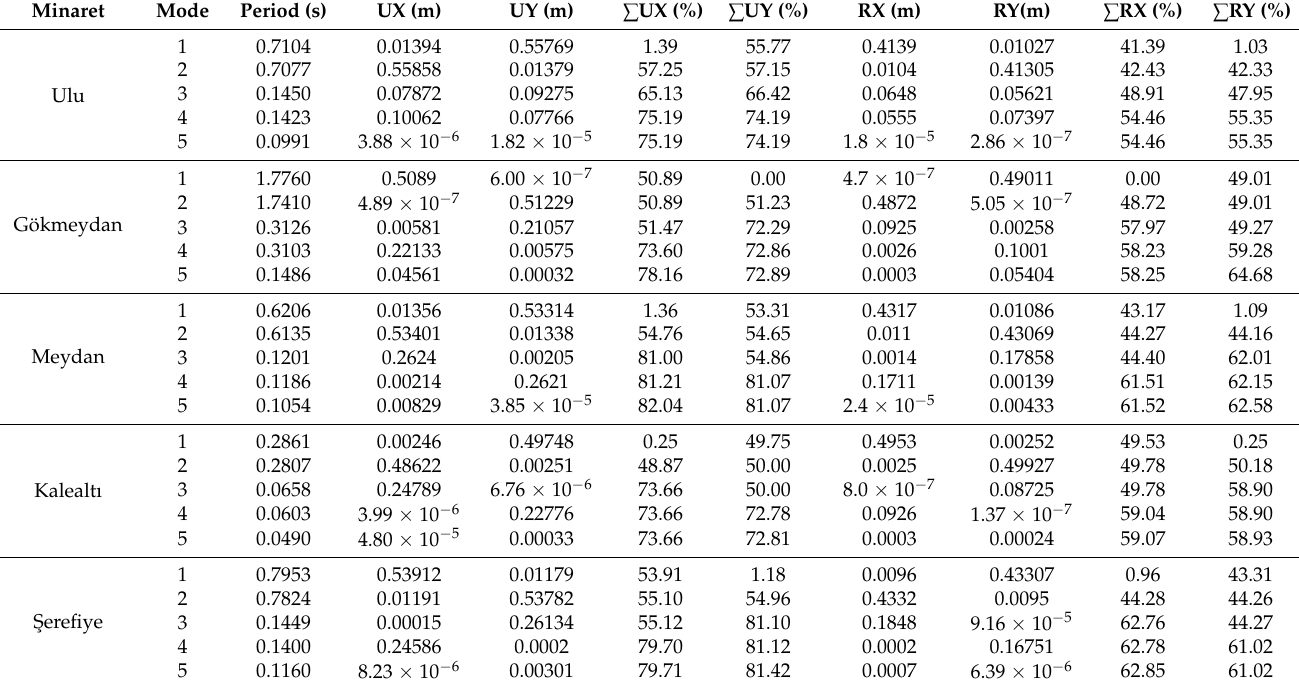
Table 5. Modal analysis results of Five Minarets.